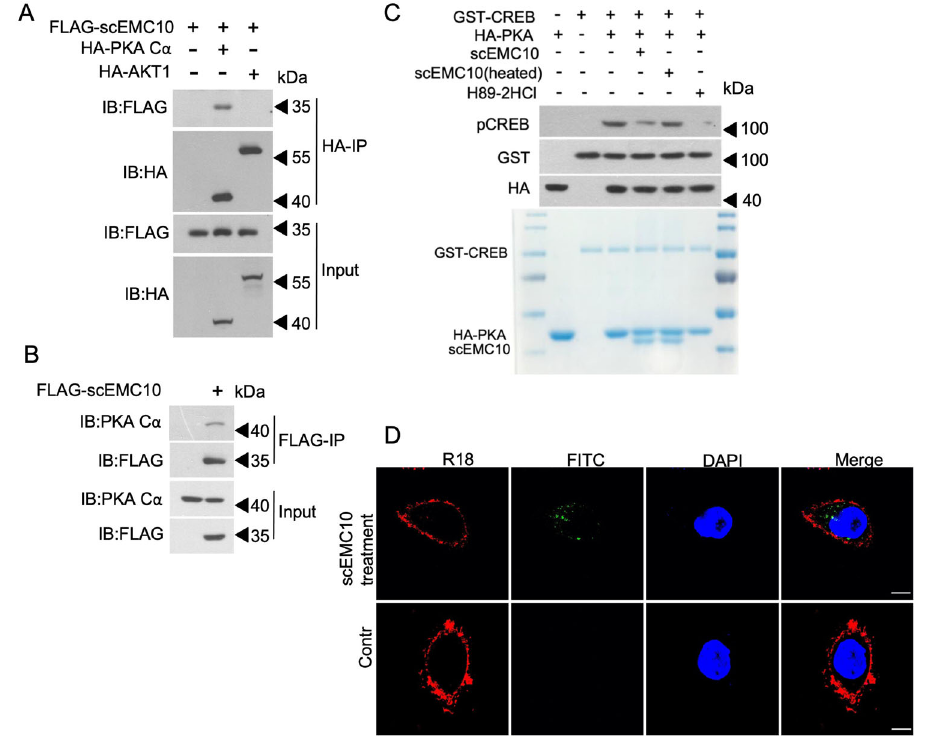
Fig. 6 | Extracellular scEMC10 bindsPKAC α andinhibitsitsstimulatory action on CREB. A Immunoprecipitation and western blotting of scEMC10, PKA C α , and AKT1incelllysatepreparedfrom293TcellstransfectedwitheitherFLAG-scEMC10 plasmid alone, or co-transfected with HA-PKA C α or HA-AKT1 plasmid. B Immunoprecipitation and westernblottingofscEMC10and endogenous PKAC α in cell lysate prepared from 293T cells transfected with FLAG-scEMC10 plasmid. C WesternblottingforpCREB,totalCREBandPKAin293Tcellsaftertreatmentwith